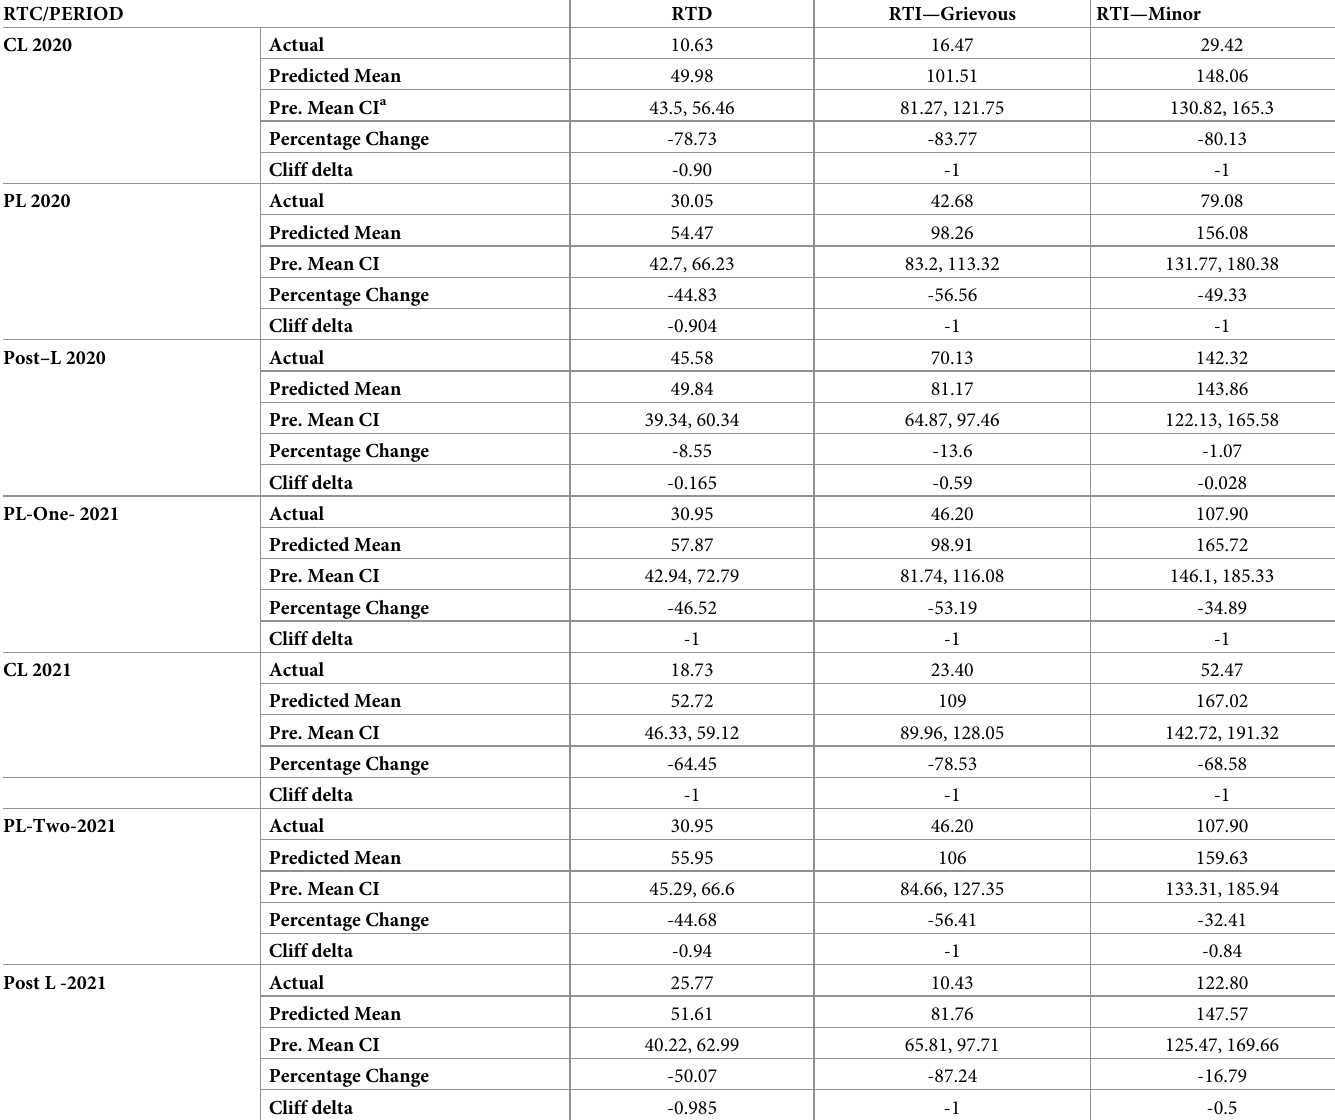
Table 4. Statistics of RTD/RTIs in all phases during both waves for